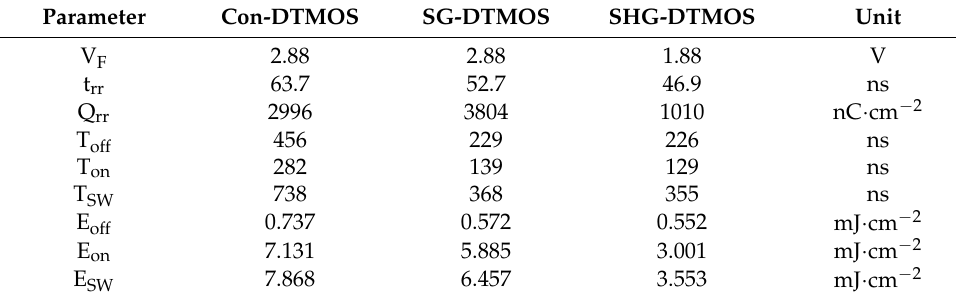
Table 3. Body diode and switching characteristics of each